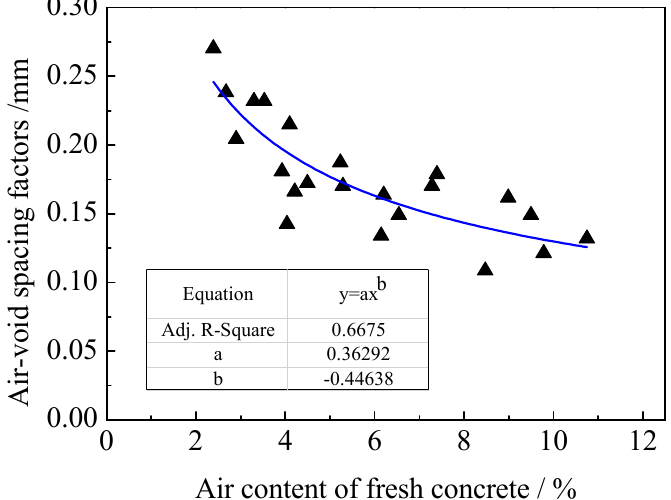
Figure 7. The relationship between air-content and the air-void spacing factor of hardened concrete.